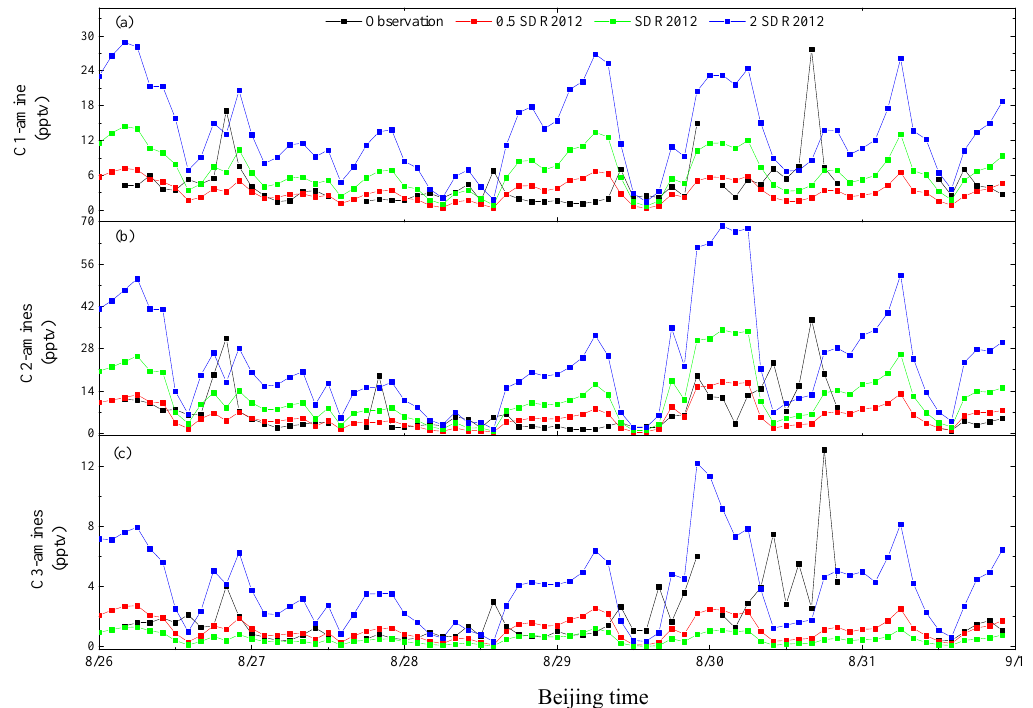
Figure 7. Comparisons of simulated concentrations of C1-, C2-, C3-amines in SDR2012, 0.5 SDR2012, and 2 SDR2012 (domain 3) at the NUIST site with measurements from 26 to 31 August 2012. Black, red, green, and blue lines present observations, simulated values in 0.5 SDR2012, SDR2012, and 2 SDR2012, respectively. Table 4. Statistical performance of methylamine simulation at the NUIST site (cases: FR2012 and SDR2012) in domain 3 and the Fudan site (cases: FR2015 and SDR2015) in both domain 3 and domain 4 (values given in parentheses). The details of each case are given in Table